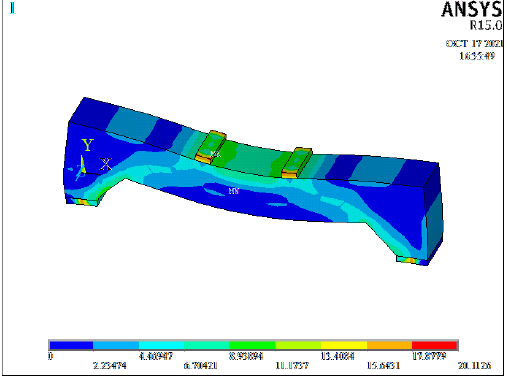
Figure 12. Contour of the von Misses stress for the typical non-prismatic RC beam model B2 (hollow).